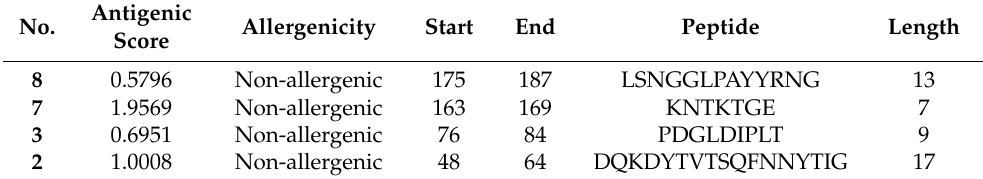
Table 2. MHC Class-I epitopes.